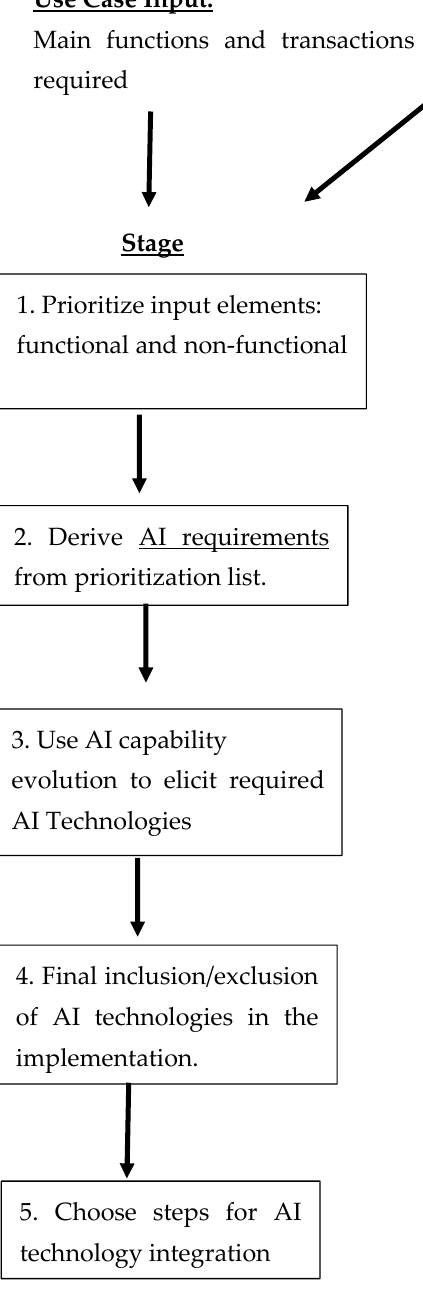
Figure 4. Proposed process for generating AI technology integration plan